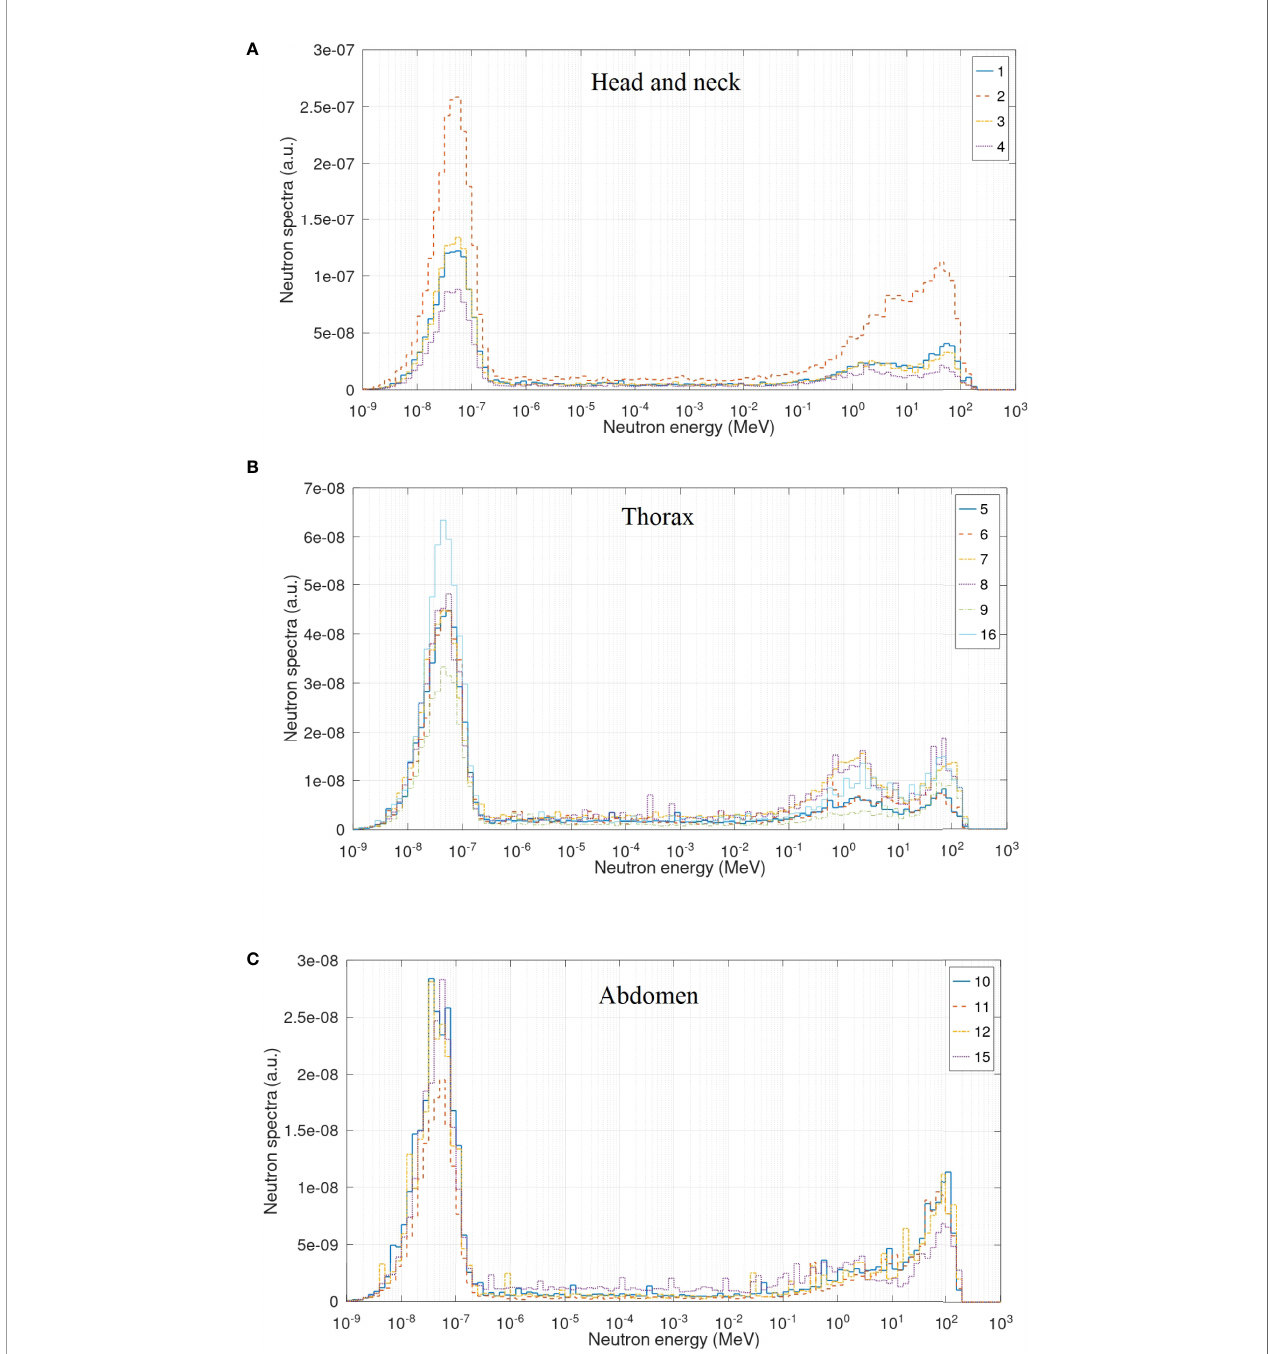
FIGURE 5 | Neutron spectra inside the NORMA phantom in the head and neck (A) , thorax (B) , and abdomen (C)